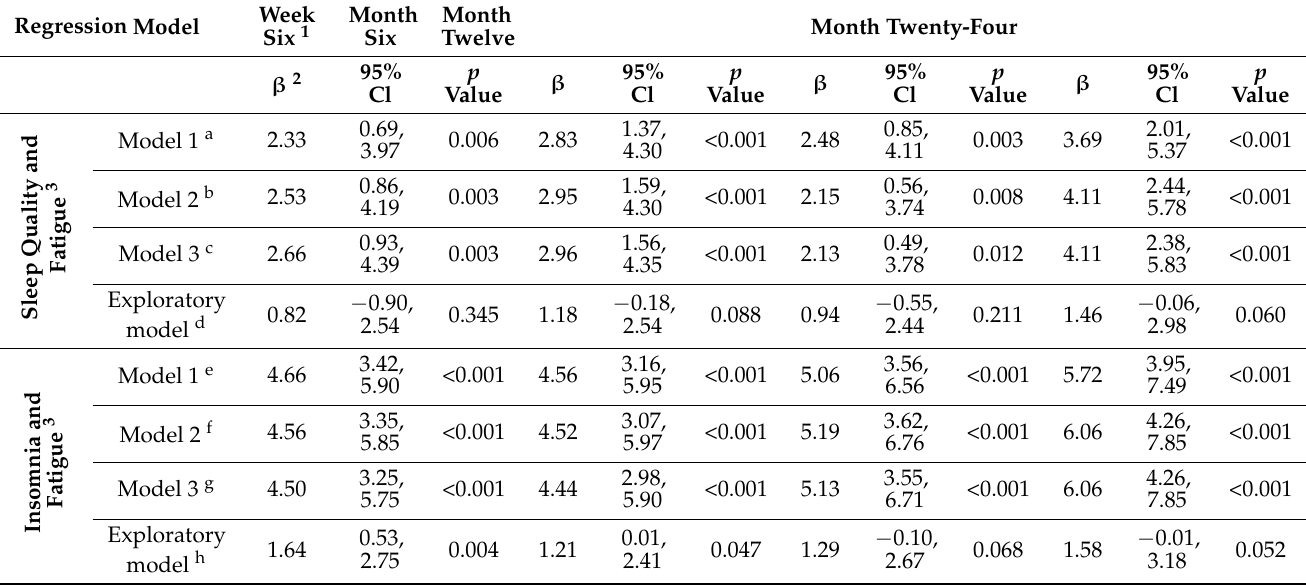
Table 2. Multiple linear regression results of sleep quality with fatigue and insomnia with fatigue at week 6, month 6, month 12, and month